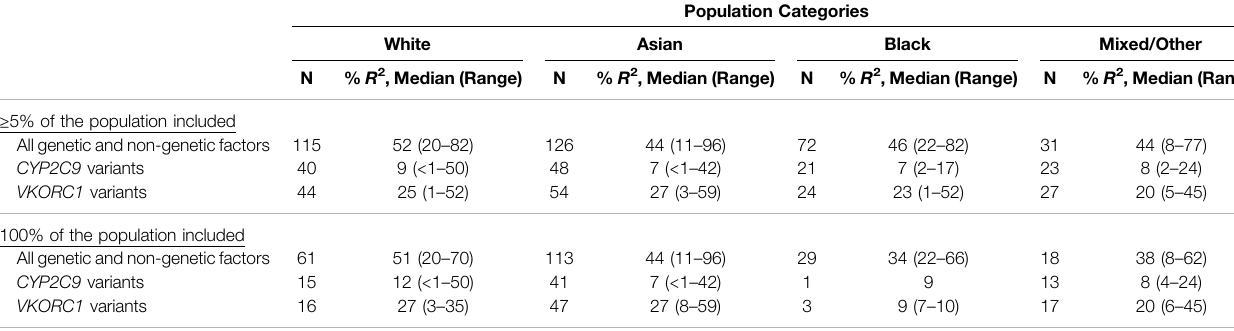
TABLE 1 | Proportion of variability explained by CYP2C9 and VKORC1 genes (Asiimwe et al.,